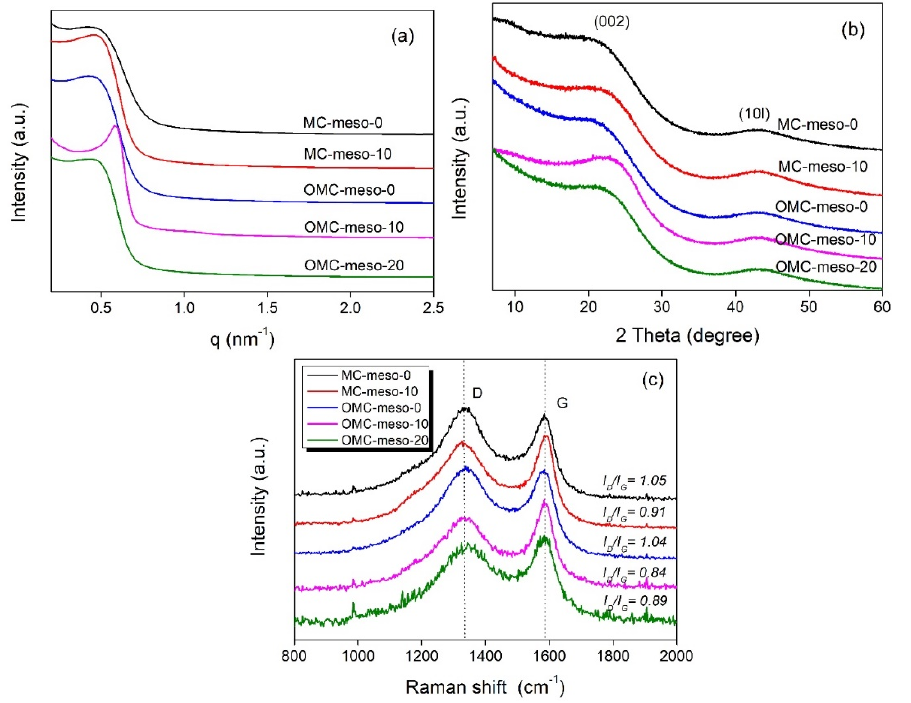
Figure 2. Small-angle ( a ) and wide-angle ( b ) XRD patterns and Raman spectra ( c ) of MCs and OMCs prepared with different amounts of mesophase pitch.